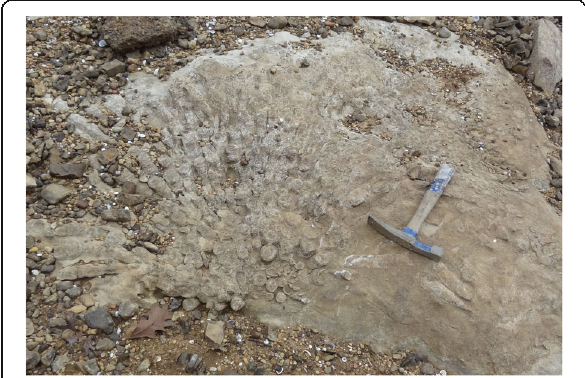
Fig. 5 Rugosan coral cluster at the type locality of Arcuodus multicuspidatus. The holotype specimen was found, displaced horizontally, at the same stratigraphic level. Rock hammer included for scale. Photograph by L. White. Used with